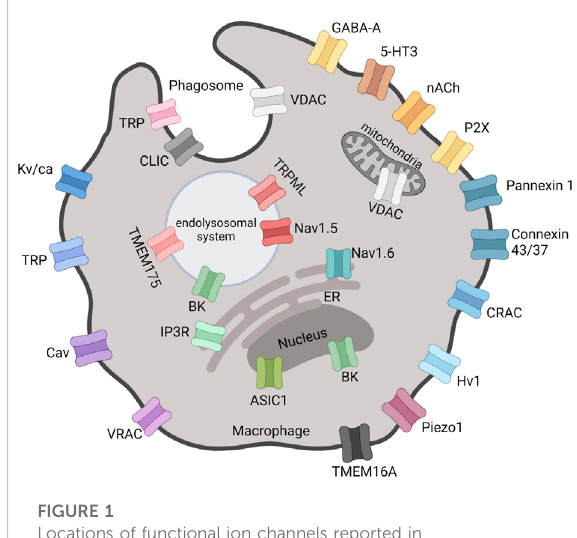
FIGURE 1 Locations of functional ion channels reported in macrophages. Mitochondria and nucleus are double-membrane- bounded organelles with ion channels located in the inner and/or outer membranes. The outer nuclear membrane is continuous with the ER. VDAC, Voltage-Dependent Anion Channel; GABA-A, Gamma-Aminobutyric Acid type A receptor; 5- HT3, 5-Hydroxytryptamine3 receptor; nACh, Nicotinic Acetylcholine receptor; CRAC, Ca 2+ Release-Activated Channel; H v , Proton voltage-gated channel; VRAC, Volume-Regulated Anion Channel; Ca v , Ca 2+ voltage-gated channel; TRP, Transient Receptor Potential; K v/Ca , K + voltage-gated and/or Ca 2+ -activated channel; BK, Big K + channel; Na v , Na + voltage-gated channel; TMEM, Transmembrane Protein; IP3R, Inositol 1,4,5-trisphosphate receptor; ER, Endoplasmic Reticulum; ASIC, Acid-Sensing Ion Channel; CLIC, Cl − Intracellular Channel. Created with